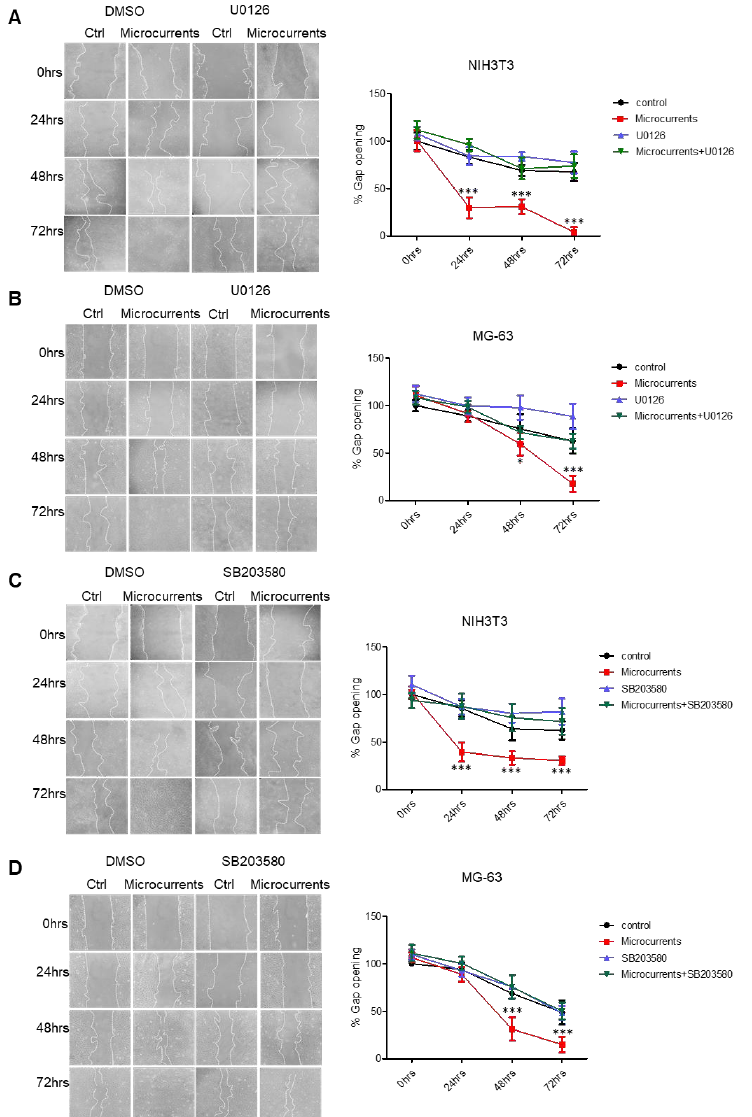
Figure 2. Stimulation with microcurrents accelerates wound closure in fibroblasts and osteoblast-like cells. ( A , B ) Representative images of a wound healing assay in NIH3T3 and MG-63 cells stimulated with microcurrents, in the presence and absence of an U0126 inhibitor. Quantification of the wound area (gap opening) was performed every 24 h. ( C , D ), Representative images of wound healing assay in NIH3T3 and MG-63 cells treated with microcurrents, in the presence and absence of p38 inhibitor, SB203580. Graphs represent the quantification of the gap opening in different time points. Microscopy imagesrecordedunderidenticalconditionswitha100 × magnificationareshown. (* p < 0.05, *** p < 0.005, N = 3, n = 3, microcurrent stimulation vs.